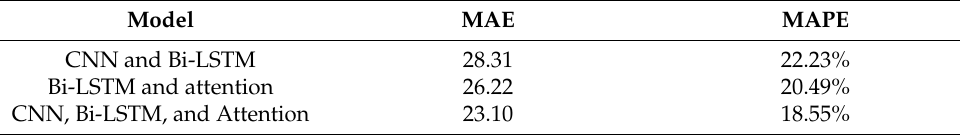
Table 8. Results of ablation